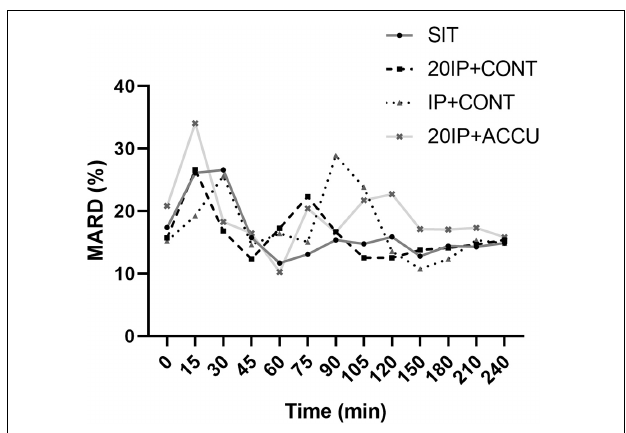
FIGURE 2 | MARD under postprandial resting and different walking conditions. MARD, mean absolute relative difference; SIT, sitting. 20iP + CONT: walking continuously for 30 min initiated 20 min before each participant’s postprandial glucose peak (PPGP); iP + CONT: walking continuously for 30 min initiated at PPGP; and 20iP + ACCU: walking accumulated for 30 min initiated 20 min before PPGP (three bouts of 10 min walking separated by 20 min of rest). One-way repeated-measures ANOVA (factor: time) was used for the comparison of MARD between time points in each